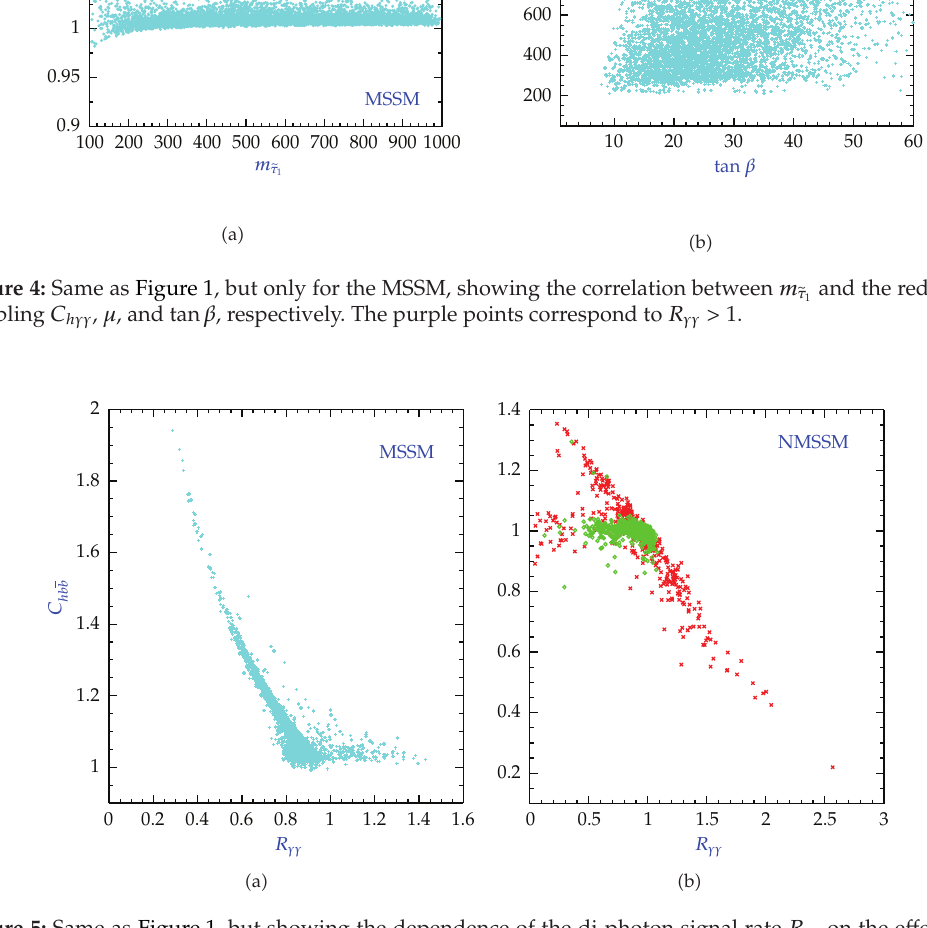
Figure 5: Same as Figure 1, but showing the dependence of the di-photon signal rate R γγ on the e ff ective ≡ C SUSY (cid:3) taken for (cid:5) 42 (cid:6)(cid:4) hbb coupling C /C SM hbb hbb hbb